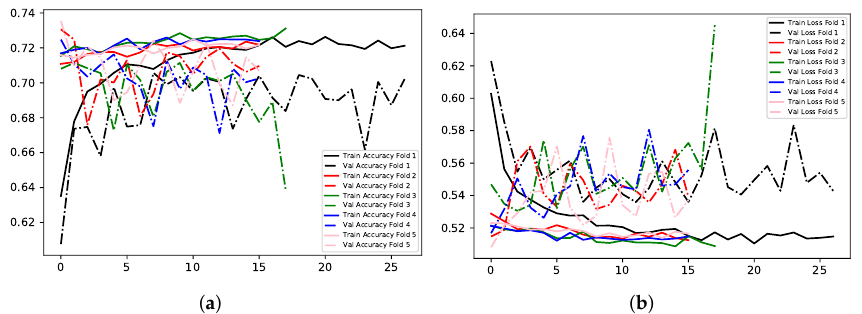
Figure 17. Model C Experiment 3 Results. ( a ) Accuracy. ( b )